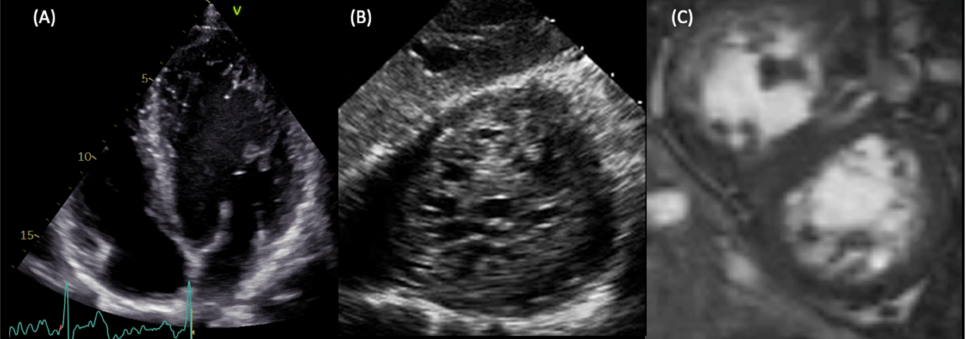
Figure 2. LVNC in a young patient with no cardiological symptoms. The patients presented at the ER with paroxysmal atrial fibrillation. Transthoracic echocardiography showed hypertrabeculated LV ( A ). During a transoesophageal echocardiogram to rule out intra-atrial clots, the deep transgastric view at 0 degrees demonstrated the spongy aspect of the apex ( B ). CMR confirmed the diagnosis of LVNC using the Peterson criteria ( C ), and showed a mildly reduced ejection